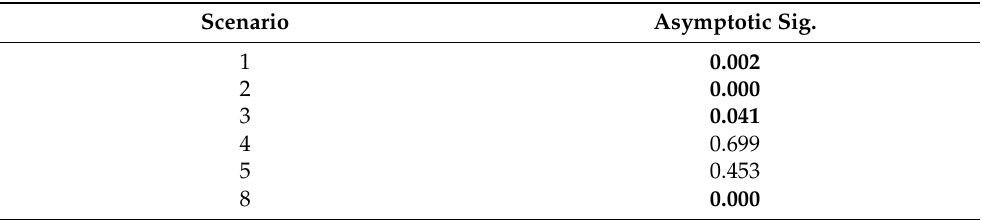
Table 2. Results of Cochran’s Q test—significant differences in traffic sign recognition between tested vehicles per analyzed